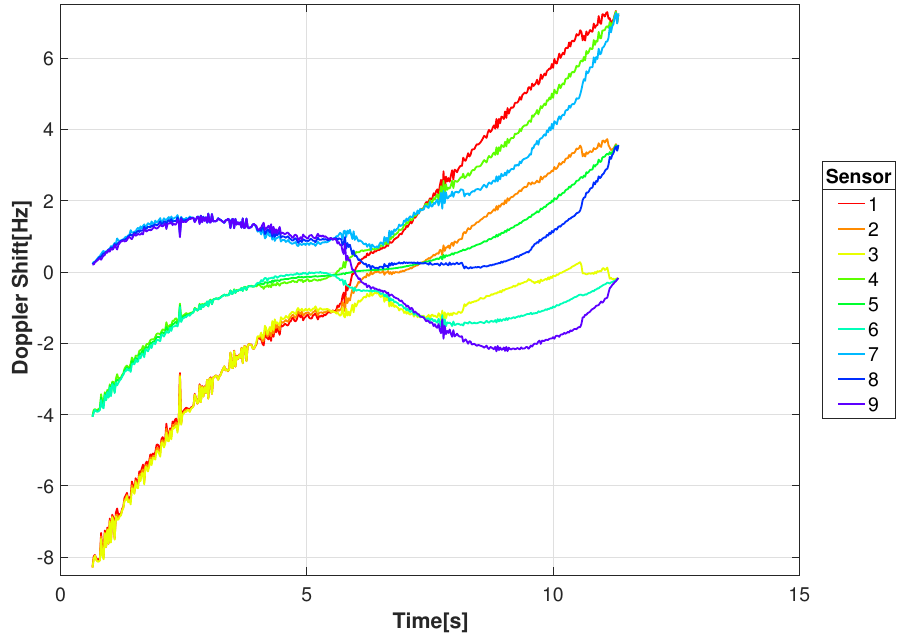
Figure 10. Example Doppler shifts for 1 GHz carrier frequency between a transmitting target (GT #1) and the locations of the RF sensor